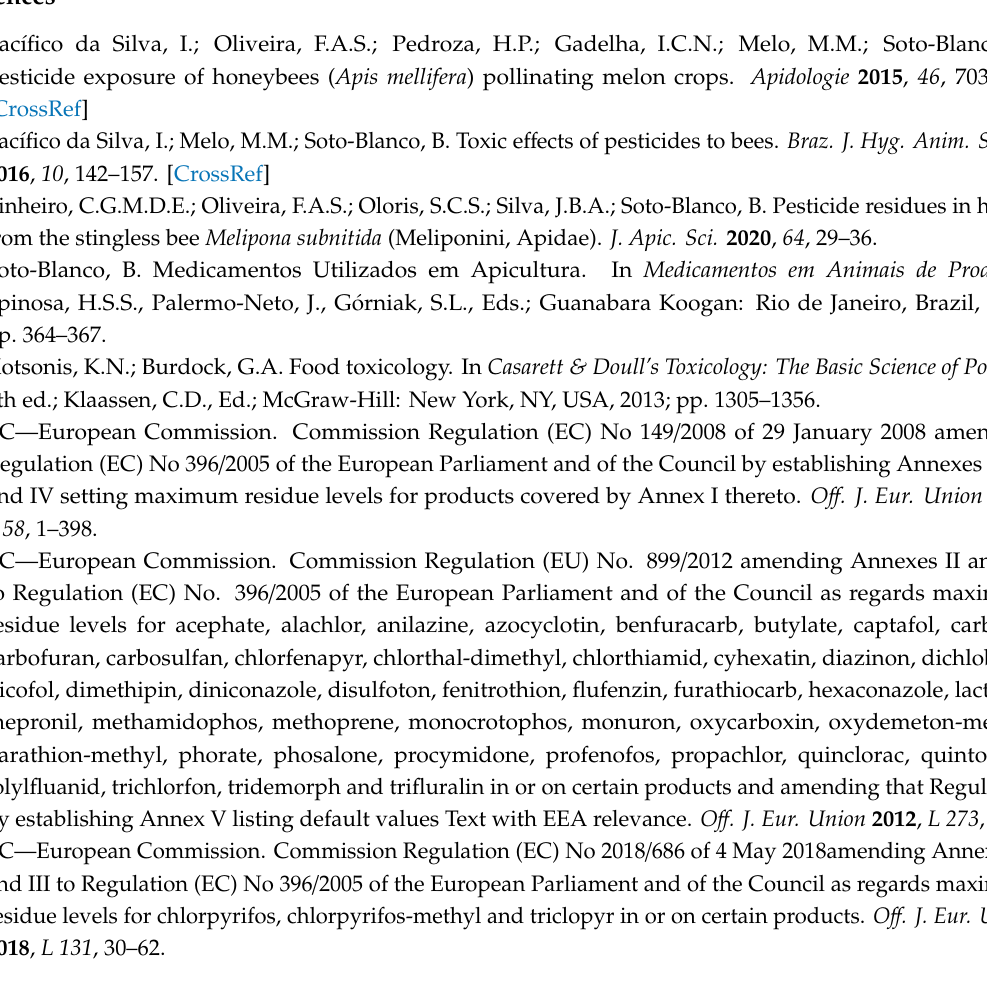
Table S1. Modified QuEChERS method optimization. Extraction with acetonitrile, or a solution of acetonitrile and ethyl acetate (70:30, v / v), and inclusion of a freezing out step prior to clean up (900 mg of anhydrous magnesium sulfate and 150 mg of PSA). Results are presented as recovery (in %) for each analyte of the LC-MS / MS; Table S2. Non-approved analytes. Linearity, recovery (in %), repeatability relative standard deviation (RSD; in %), expanded measurement uncertainty (U; in %), limit of detection (LOD; in mg / kg), and limit of quantification (LOQ; in mg / kg) for each analyte of the LC-MS / MS method for analysis of pesticides in honey; Table S3: Non-approved analytes. Linearity, recovery (in %), repeatability relative standard deviation (RSD; in %), expanded measurement uncertainty (U; in %), limit of detection (LOD; in mg / kg), and limit of quantification (LOQ; in mg / kg) for each analyte of the GC-MS / MS method for analysis of pesticides in